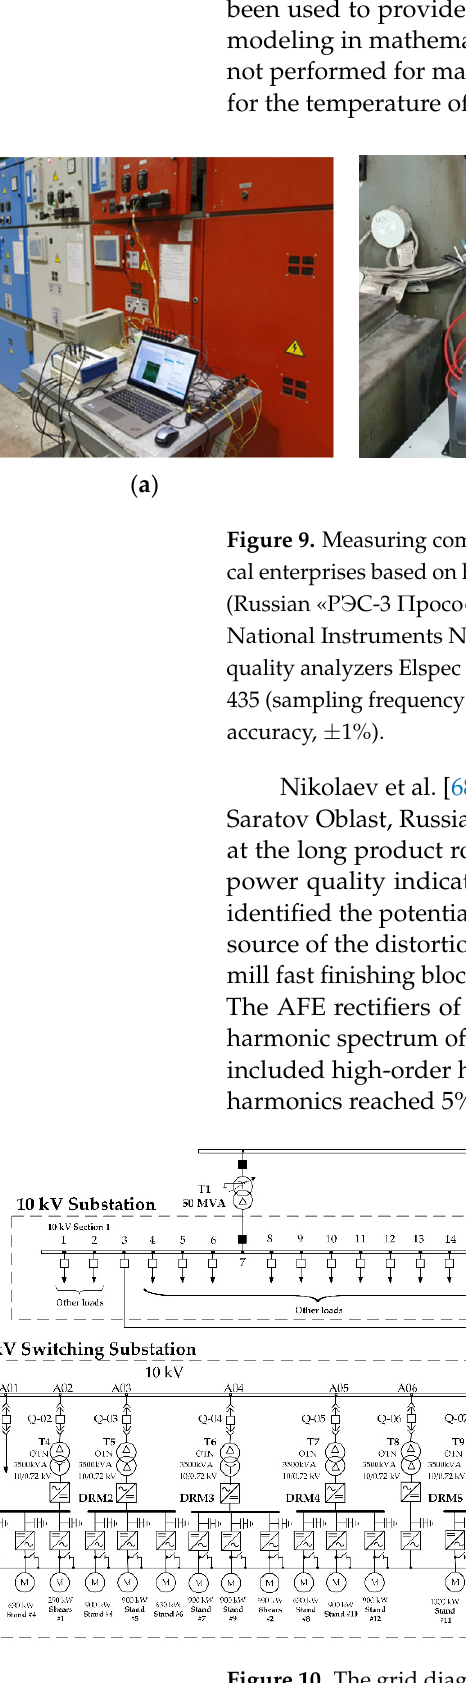
( b ) Figure 11. The immediate values of the line voltage in the 10 kV buses ( a ) and their harmonic spec- trum ( b ). The significant distortions of the grid voltage in the 10 kV caused the following situ- ations: (1) the erratic generation of control impulses leads to the currents of the AFE recti- fier block of electric drive frequency converters in other bar mill stands that work in par- allel to be divided unevenly, and one of the modules is overloaded by current; (2) the short-term impulse failure results in a DC short-circuit in two transistors of the same phase. Any of the mentioned situations may result in the failure of the converters. Nikolaev et al. [70] described the electromagnetic compatibility problems of fre- quency converters and AFE rectifiers with the 34.5 kV power grid at MMK Metalurji in Turkey. During the commissioning of the 1750 hot-rolling mill (HSM) and 1750 reserve cold-rolling mill (CRM), it turned out to be impossible to operate in the standard power supply mode when the two rolling mills and other secondary consumers were energized by one 380/34.5 kV step-down transformer (Figure 12).